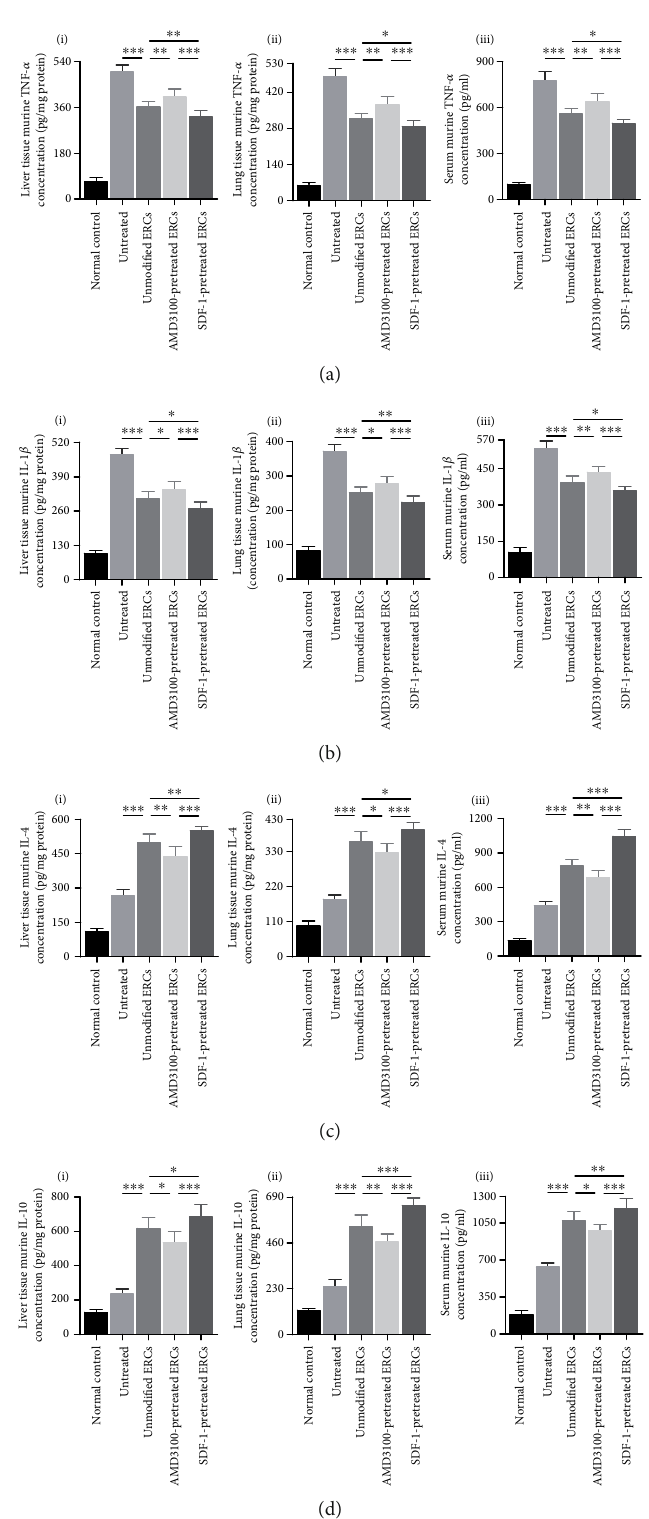
Figure 5: Pretreatment with SDF-1 further enhanced the anti-in fl ammatory e ff ect of ERCs in the process of sepsis. The protein concentration of murine TNF- α (a), IL-1 β (b), IL-4 (c), and IL-10 (d) in the liver, lung, and serum. Statistical analysis was performed by one-way ANOVA followed by the LSD test, n = 6 . ∗ p < 0 : 05 , ∗∗ p < 0 : 01 , and ∗∗∗ p < 0 : 001 . Bar graphs represent mean ± SD . Abbreviation: ERCs: endometrial regenerative